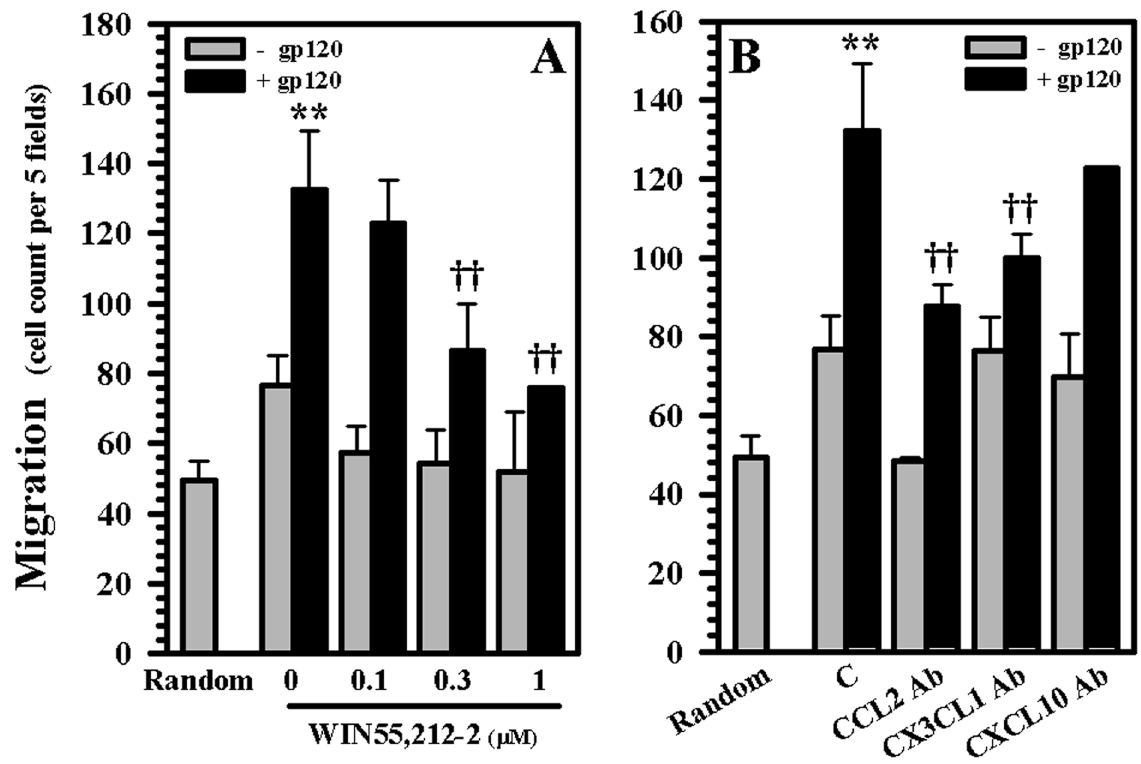
Figure 10. Blockade of human microglial migration towards supernatants from human mesencephalic neuronal/glial cultures. A ) Human mesencephalic neuronal/glial cultures were pretreated with WIN55,212-2 (0.1 to 1 μM) for 3h followed by either no treatment or gp120 (10 nM) treatment for 72h. Supernatants were then collected for the chemotaxis assay. Highly purified human microglia were added to upper chambers with the lower chambers filled with supernatants from the human mesencephalic neuronal/glial cultures. After 3 h of incubation, human microglia that had migrated from upper chambers into lower chambers were quantified by Diff-Quik staining. B ) Antibodies for chemokines CCL2, CX3CL1 and CXCL10 were added to collected supernatants for 30 min prior to chemotaxis assay. Data are mean ± SEM of triplicates of 3 separate experiments using different brain tissue specimens. **p<0.01 vs. control, ††p<0.01 vs.